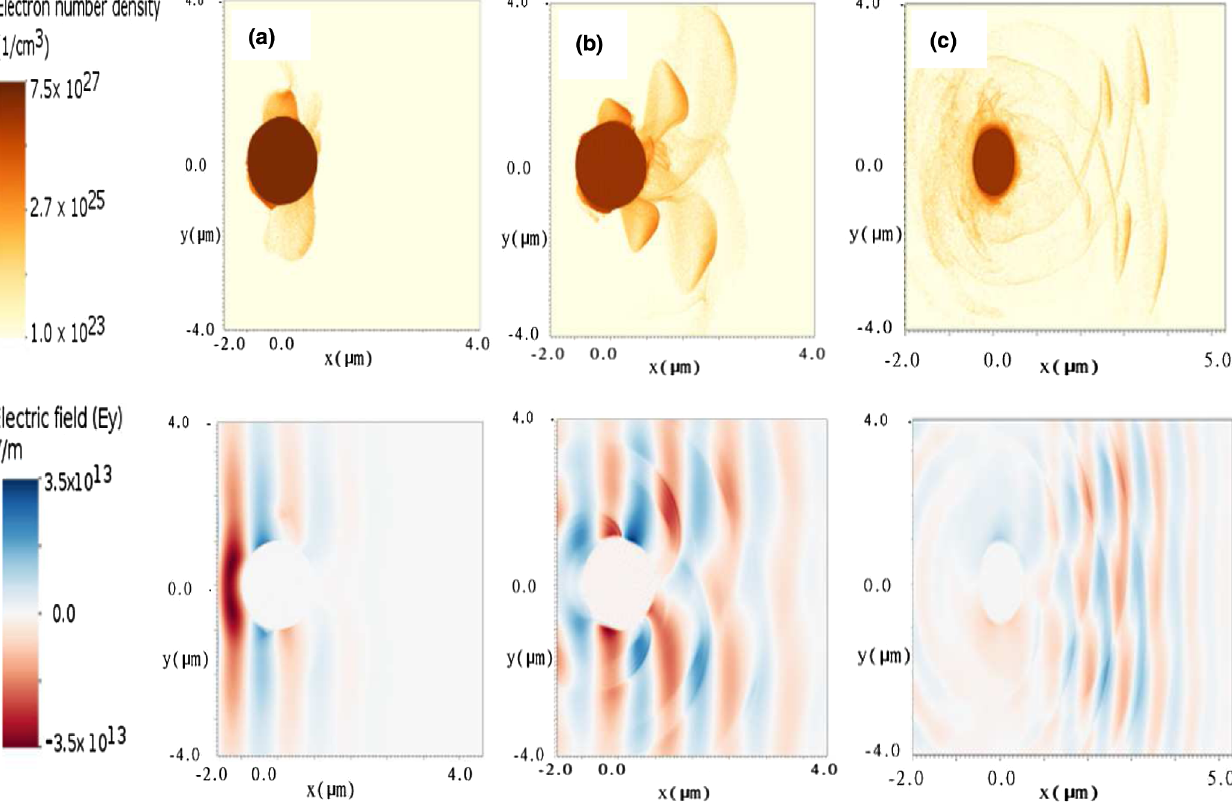
FIG. 9. Electric transverse field (in V = m), and electron density (in m − 3 ) plot for a 500 nm radius droplet hit by a laser pulse of intensity I ¼ 10 20 W = cm 2 at times (a) 3 fs, (b) 8 fs, (c) 16 fs, respectively. Angles are measured considering the center of the most dense region of the bunch. In the density scale, the maximum value corresponds to the critical density 1 . 8 × 10 27 m − 3 . The maximum absolute value of the electric field is 2 . 5 × 10 13 V =